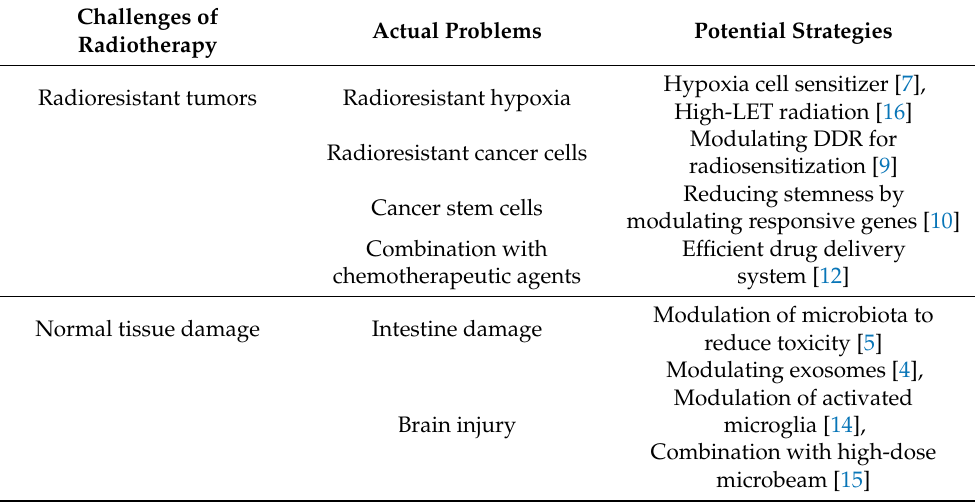
Table 1. Challenges of radiotherapy and how to solve actual treatment problems are discussed in this Special